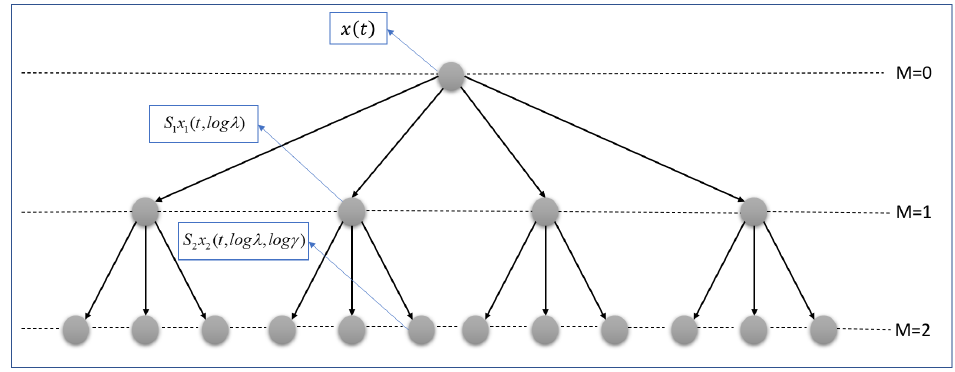
Figure 5. Hierarchical form of WST at first and second filter banks of the proposed